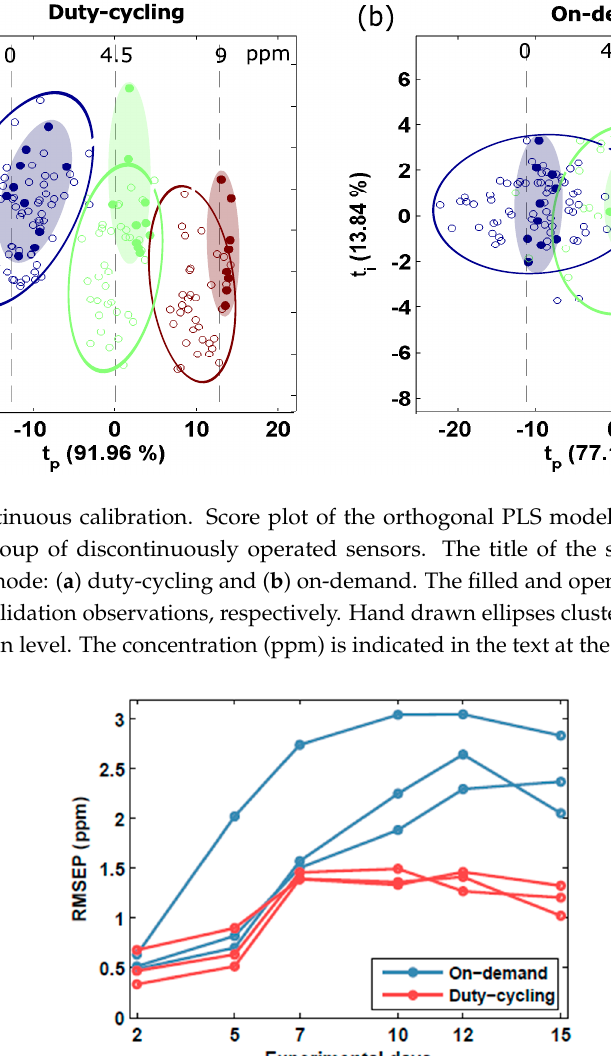
Figure 8. Temporal stability of duty-cycling and on-demand modes, after discontinuous calibration. RMSEP: root mean squared error in prediction.